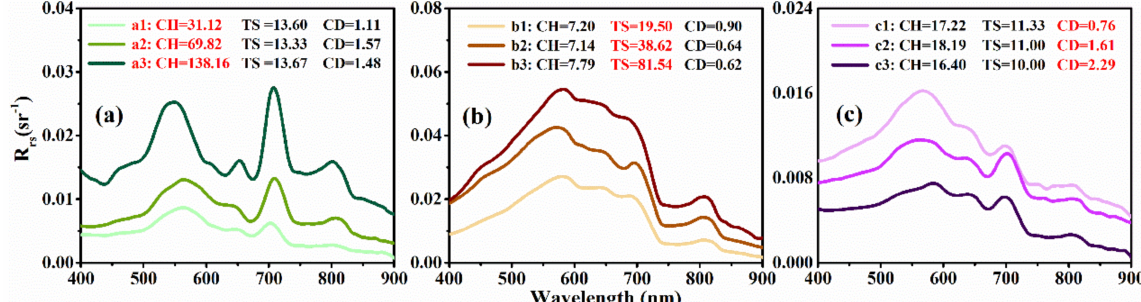
Figure 8. R rs values of the Chla concentration (CH, mg/m 3 ), TSM concentration (TS, mg/L), and a CDOM(440) (CD, m − 1 ) in different ranges. The typical R rs spectra of OWT5: a1 (OWT5, Wuxi), a2 (OWT5, Wuxi), and a3 (OWT5, Wuxi) ( a ). The typical R rs spectra of OWT2: b1 (OWT3, Wuxi), b2 (OWT2, Nanjing), and b3 (OWT3, Changzhou) ( b ). The typical R rs spectra of OWT6: c1 (OWT6, Wuxi), c2 (OWT6, Wuxi), and c3 (OWT6, Wuxi) ( c ).